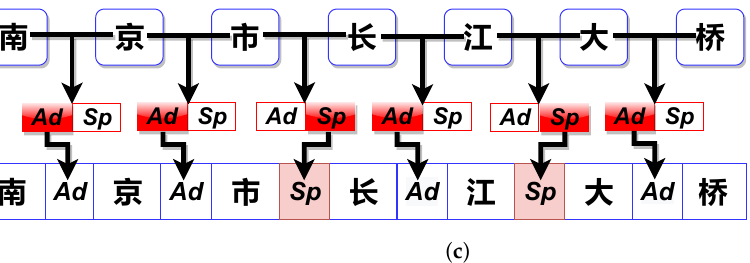
Figure 2. Existing WS algorithm v.s. Proposed SpIn. The Chinese sentece indicates “Nanjing Yangtze River Bridge”. ( a ) is the input sentence with its ground-truth segmentation at the left half and its potential segmentation on the right half. The proper word segmentation (left, about the bridge) and the improper segmentation (right, about the mayor) of the input. In ( b ), red arrows and circles stand for the correct tag sequence while the pink ones are improper. Existing WS algorithm based on the BMES tagging schema. In ( c ), states between characters rendered by red are the correct ones. Substituting the light red “Sp” with segmentation notations will give the word segmentation